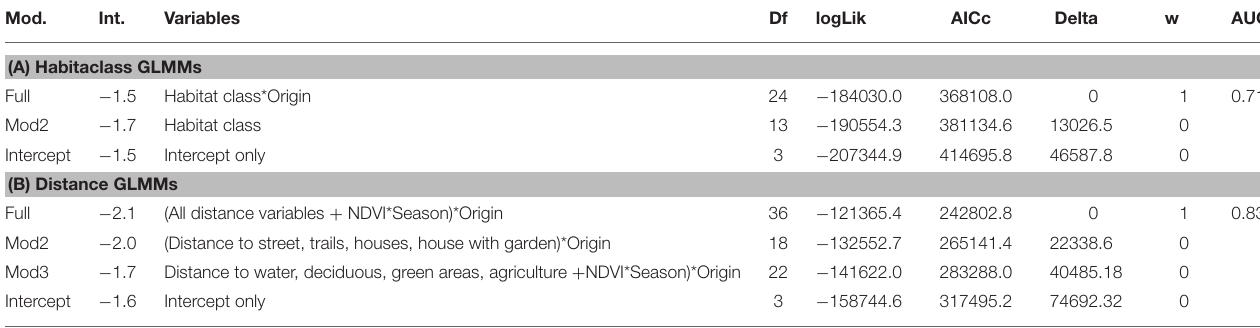
TABLE 1 | Model selection table for the influence of landscape variables on habitat choice of wild boar in Berlin and Brandenburg between 2013 and 2015.